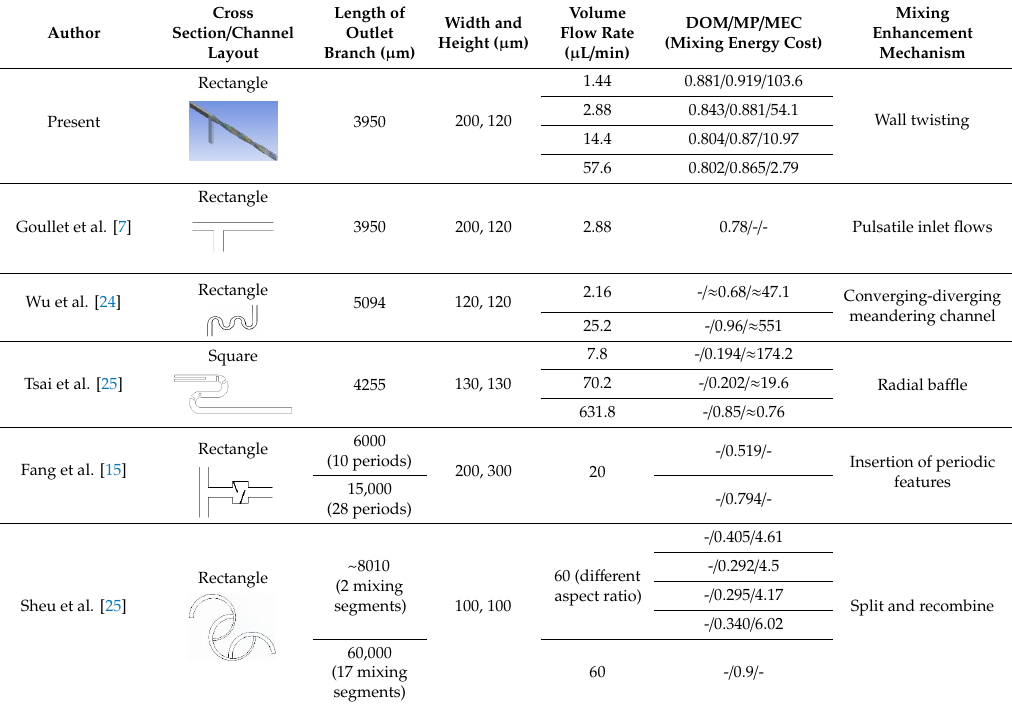
Table 1. Comparison of mixing performance.